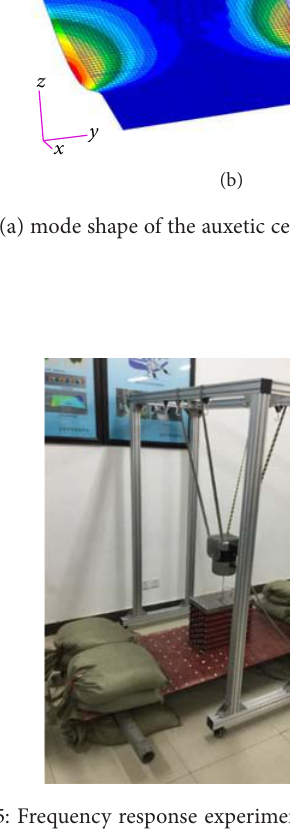
Figure 25: Frequency response experiment of the auxetic cellular